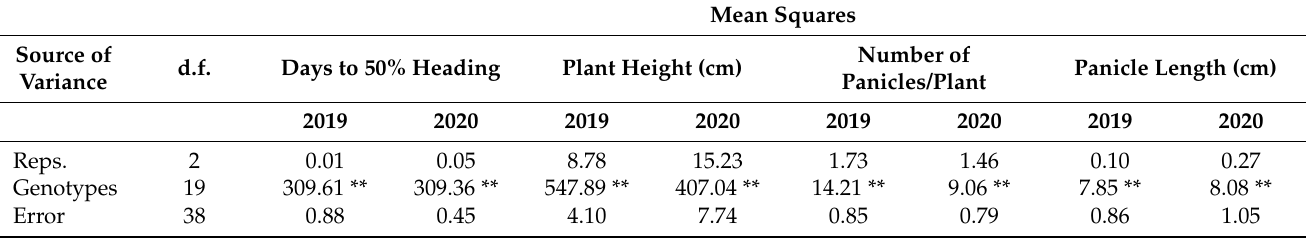
Table 2. Analysis of variances of days to 50% heading, plant height, number of panicles/plant and panicle length of twenty rice genotypes over two years.